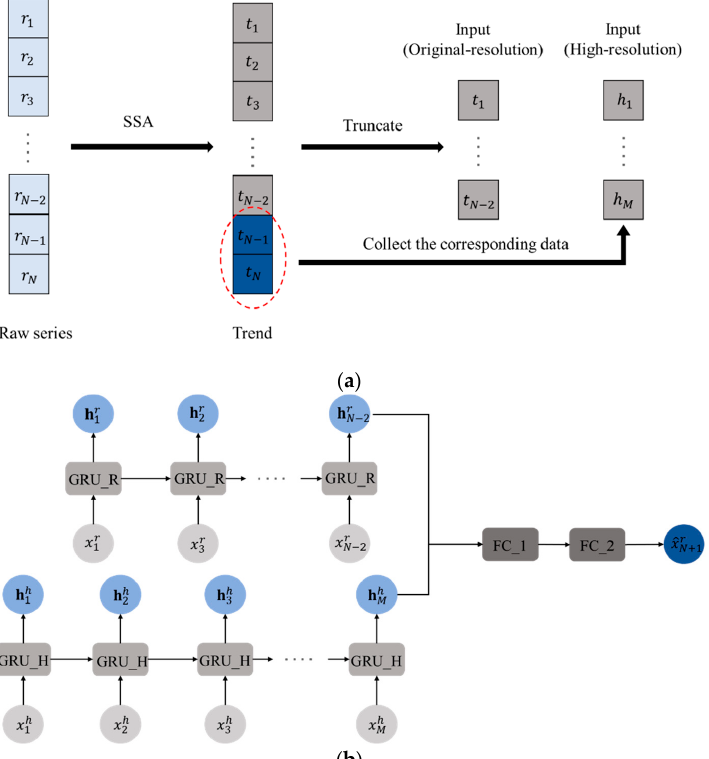
Figure 3. Diagrams of the proposed scheme and model: ( a ) multi-resolution real-time decomposition; ( b ) SSA-TRTD-MR-GRU.